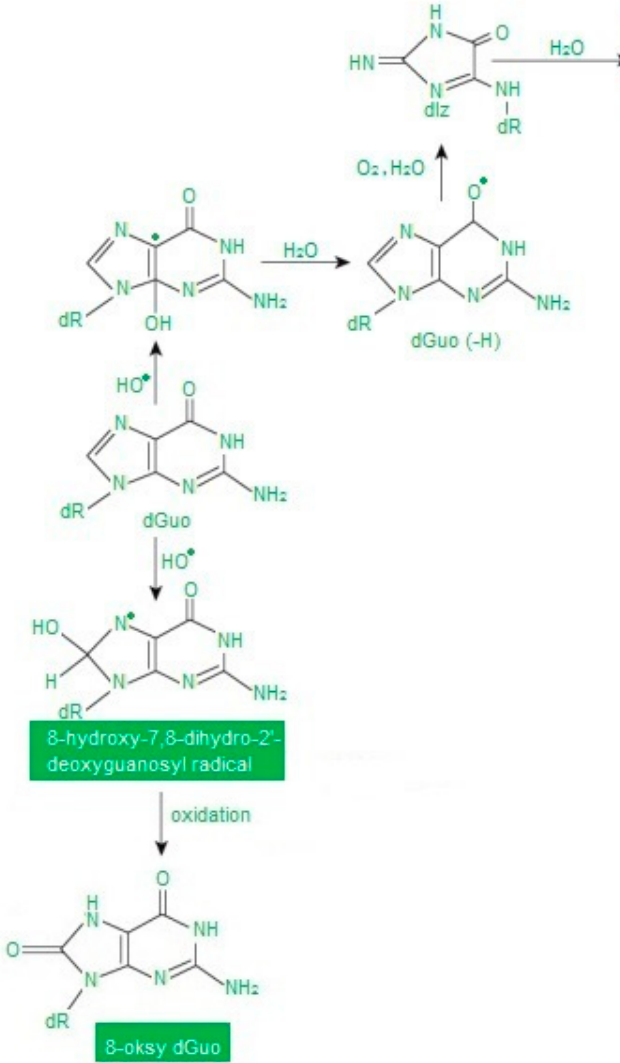
Figure 4. Abbreviation: dGuo—deoxyguanosine. Oxidative modifications of guanine according to [38] as modified by the authors.